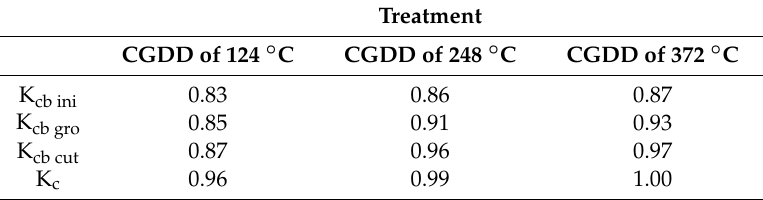
Table 8. Standard crop coefficients for Tifton 85 bermudagrass as dependent on the frequency of